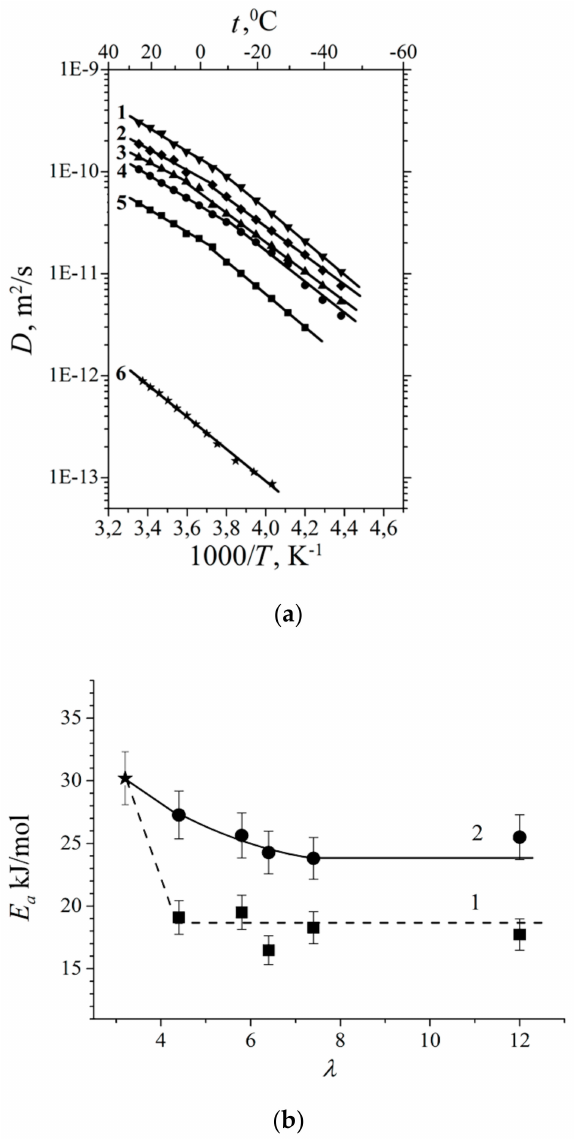
Figure 29. ( a ) The temperature dependences of average H+ and water-self diffusion coefficients for Nafion 117 membrane with different water content: curve (1) λ is 12; curve (2) λ is 7.4; curve (3) λ is 6.4; curve (4) λ is 5.8; curve (5) λ is 4.4; and curve (6) λ is 3.2; ( b )water self-diffusion activation energies in high temperature region (squares—curve 1) and low temperature region (circles—curve 2). Reprinted with permission from [25]. Copyright 2019 Springer